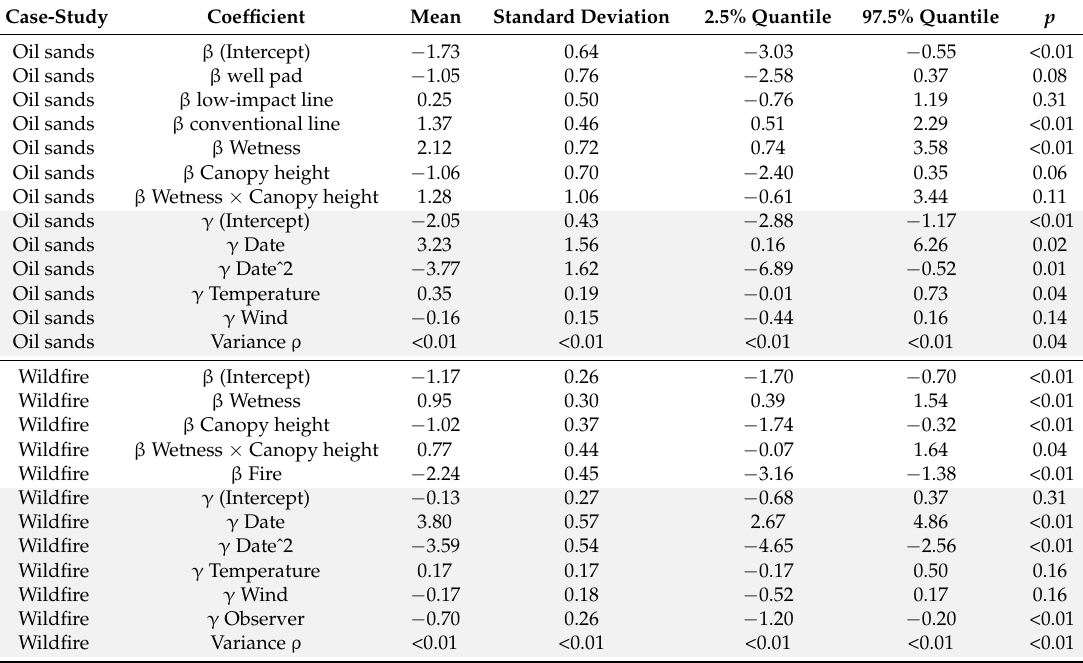
Table A1. Posterior mean, standard deviation, 2.5% quantile, and 97.5% quantile of the effects of model covariates on cranberry blue detection ( γ coefficients) and abundance ( β coefficients), including a conditional autoregressive component to account for spatial autocorrelation in abundance of cranberry blues between sampling locations closer than 300 m (Variance ρ ); p = probability that a posterior estimate is equal to zero or opposite in sign to the posterior